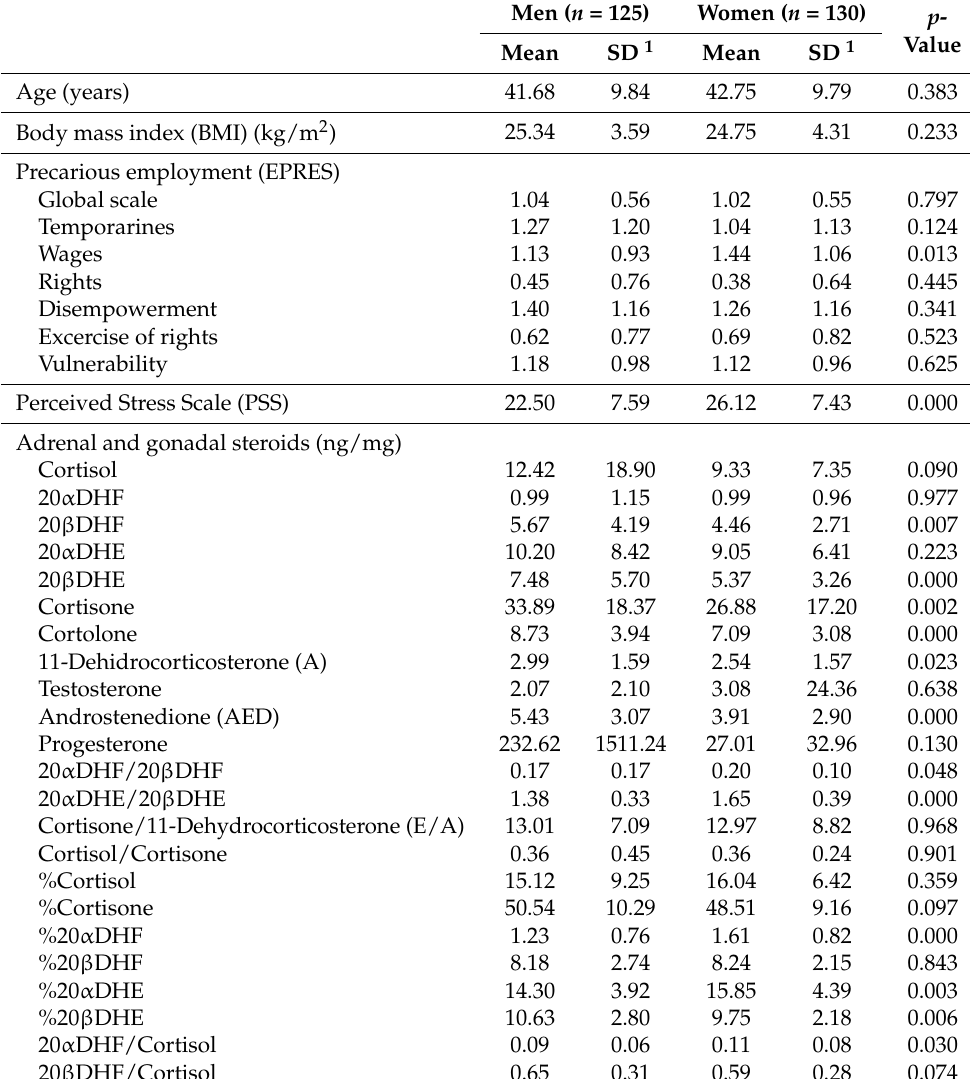
Table 1. Characteristics of the study population stratified by sex. Precarious Employment and Stress Study sample, 2020. [SD = Standard